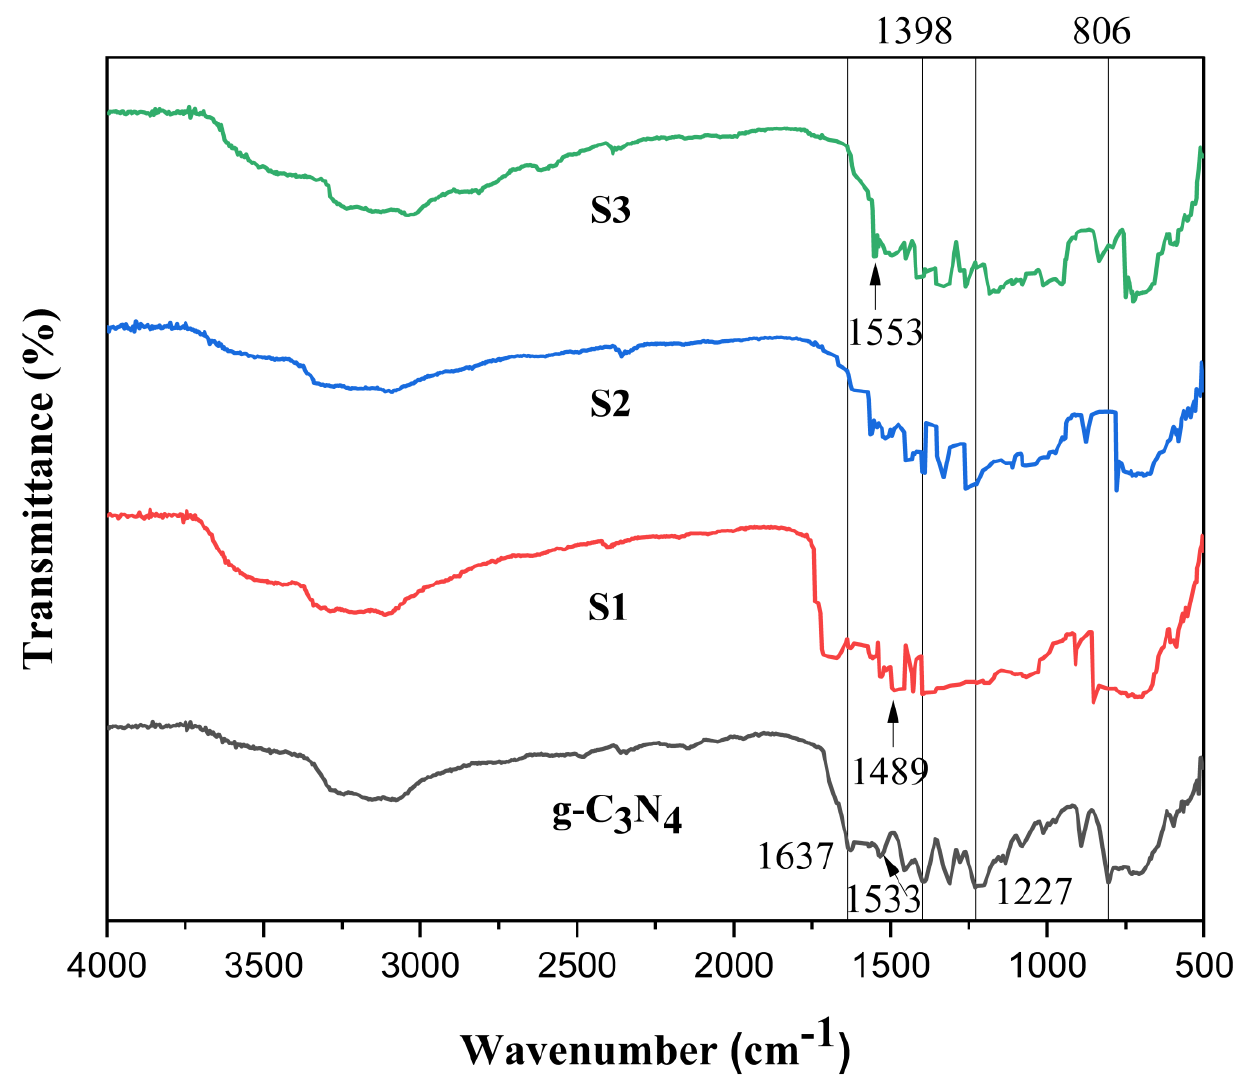
Figure 2. FTIR of g-C 3 N 4 , S1, S2, and S3 POA/g-C 3 N 4 /ZnO composites.